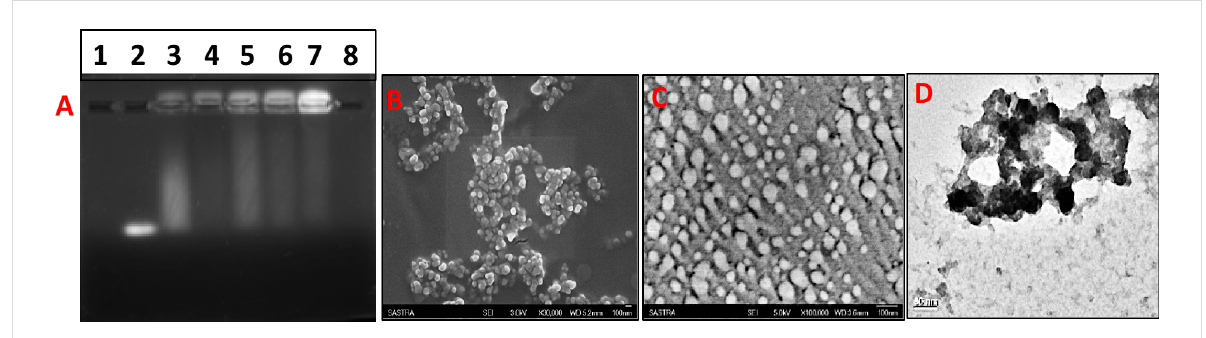
Figure 1: (A) Gel retardation assay for polyplexes formed with different ratios (v/v) of PVI/siRNA. Ethidium bromide dye (2 µg/mL) was used. The bands were visualized using UV transillumination. Lane 1: blank; lane 2: free siRNA; lane 3: polyplex formed with a 1:1 ratio of PVI/siRNA; lane 4: polyplex formed with a 2:1 ratio of PVI/siRNA; lane 5: polyplex formed with a 3:1 ratio of PVI/siRNA; lane 6: polyplex formed with a 4:1 ratio of PVI/siRNA; lane 7: polyplex formed with a 8:1 ratio of PVI/siRNA; lane 8: blank. (B) Scanning electron micrograph of blank polymer nanoparticles.